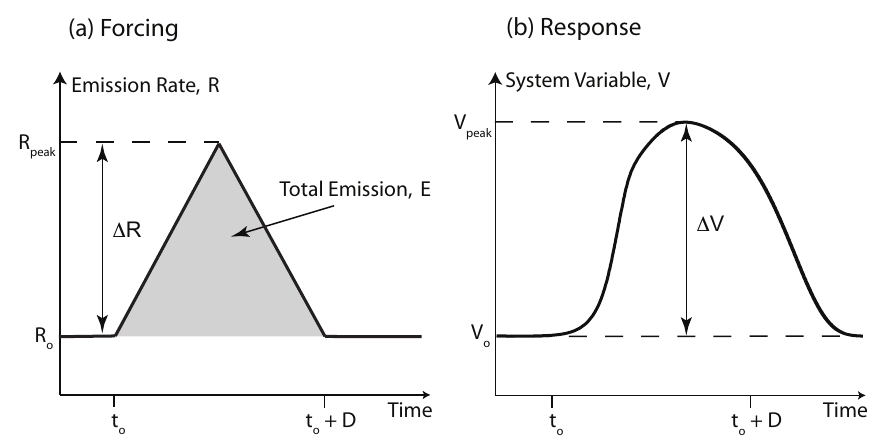
Figure 1. Schematic representations of the forcing and nature of system response. (a) Triangular atmospheric CO 2 perturbation characterized by duration, D , and total size of emission, E . (b) Typical system variable response to forcing. We define the peak system response as (cid:49)V = | V peak − V o |